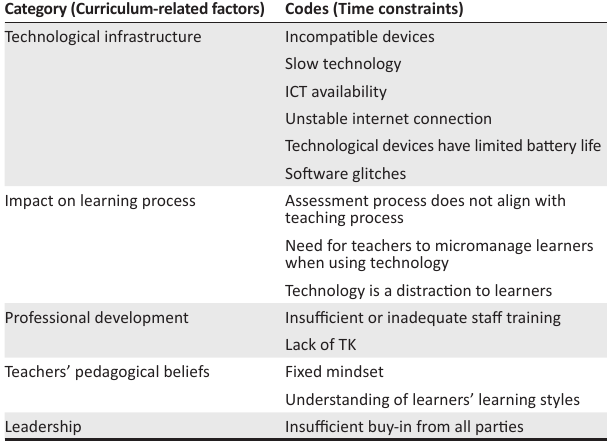
TABLE 6: Themes, categories and codes for qualitative data analysis. Theme: Barriers to integrating